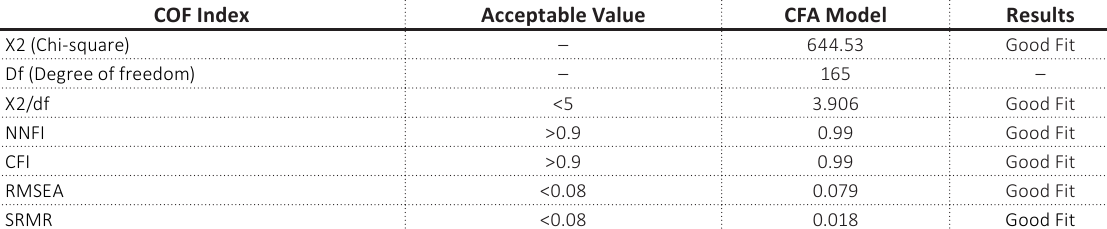
Table 3. Confirmatory factor analysis